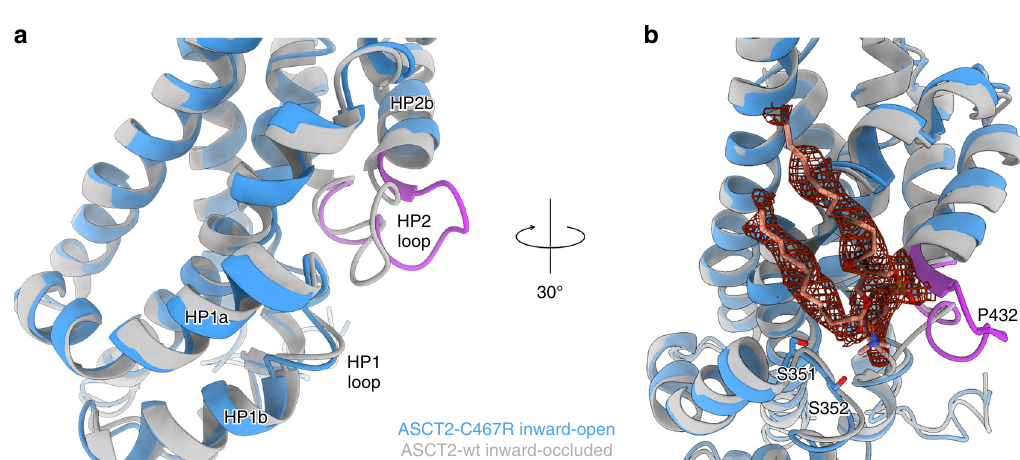
Fig. 3 Substrate-binding site and movement of the HP2 loop. a , b Superposition of the inward-open ASCT2 C467R in presence of TBOA (shown in blue with the HP2 loop in purple) and the substrate-bound inward-occluded ASCT2 wt (shown in grey, PDB-ID: 6GCT), demonstrating the movement of HP2. b Non- protein density (shown as red mesh at 3 σ ) located near HP1 and HP2 with a modelled diundecylphosphidylcholine and putatively coordinating residues shown as sticks. The lipid head group is positioned between the HP1 and HP2 loops and its negative charge appears to be stabilised by the helix dipole of hairpin helix HP2b. a , b Structures were superimposed on the transport